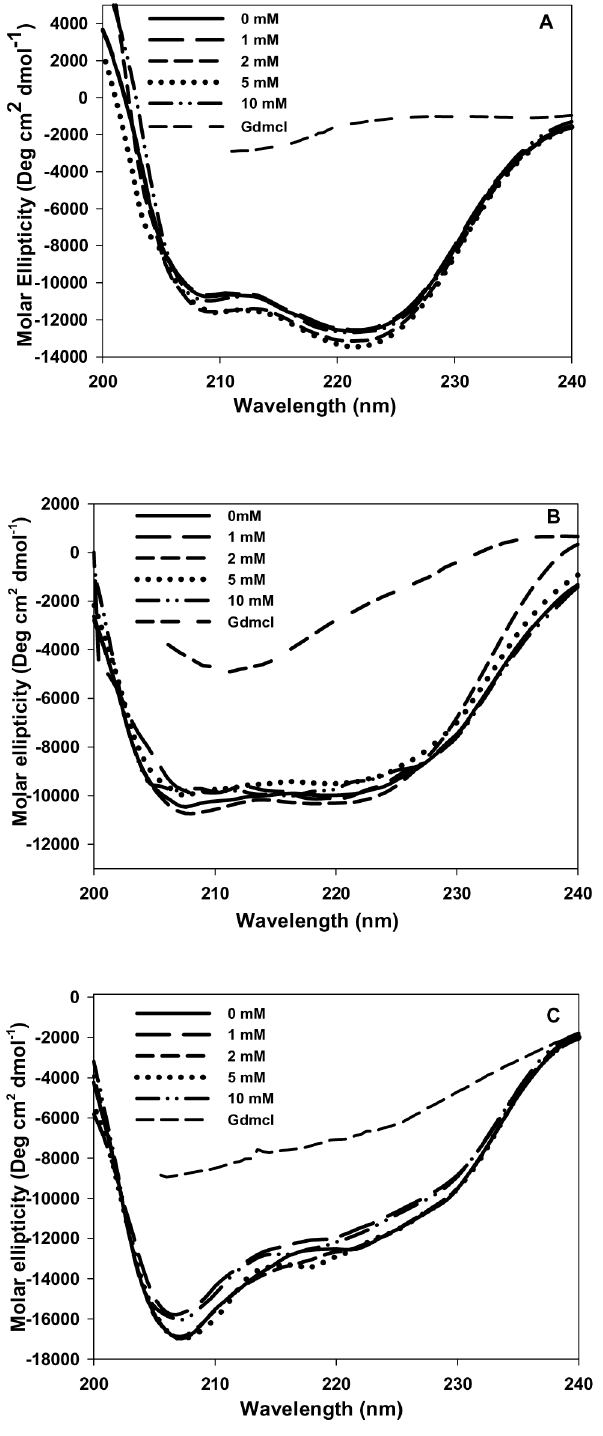
Figure 2. Effect of homocysteine thiolactone (HTL) on the secondary structure of the native state of proteins. Far UV CD spectra of (A) cyt-c (at 18 hours), (B) a -LA (at 4 hours) and (C) lysozyme at (24 hours) modified with different concentrations of HTL. Unfolded state control (7.0 M GdmCl) have also been shown for each protein.